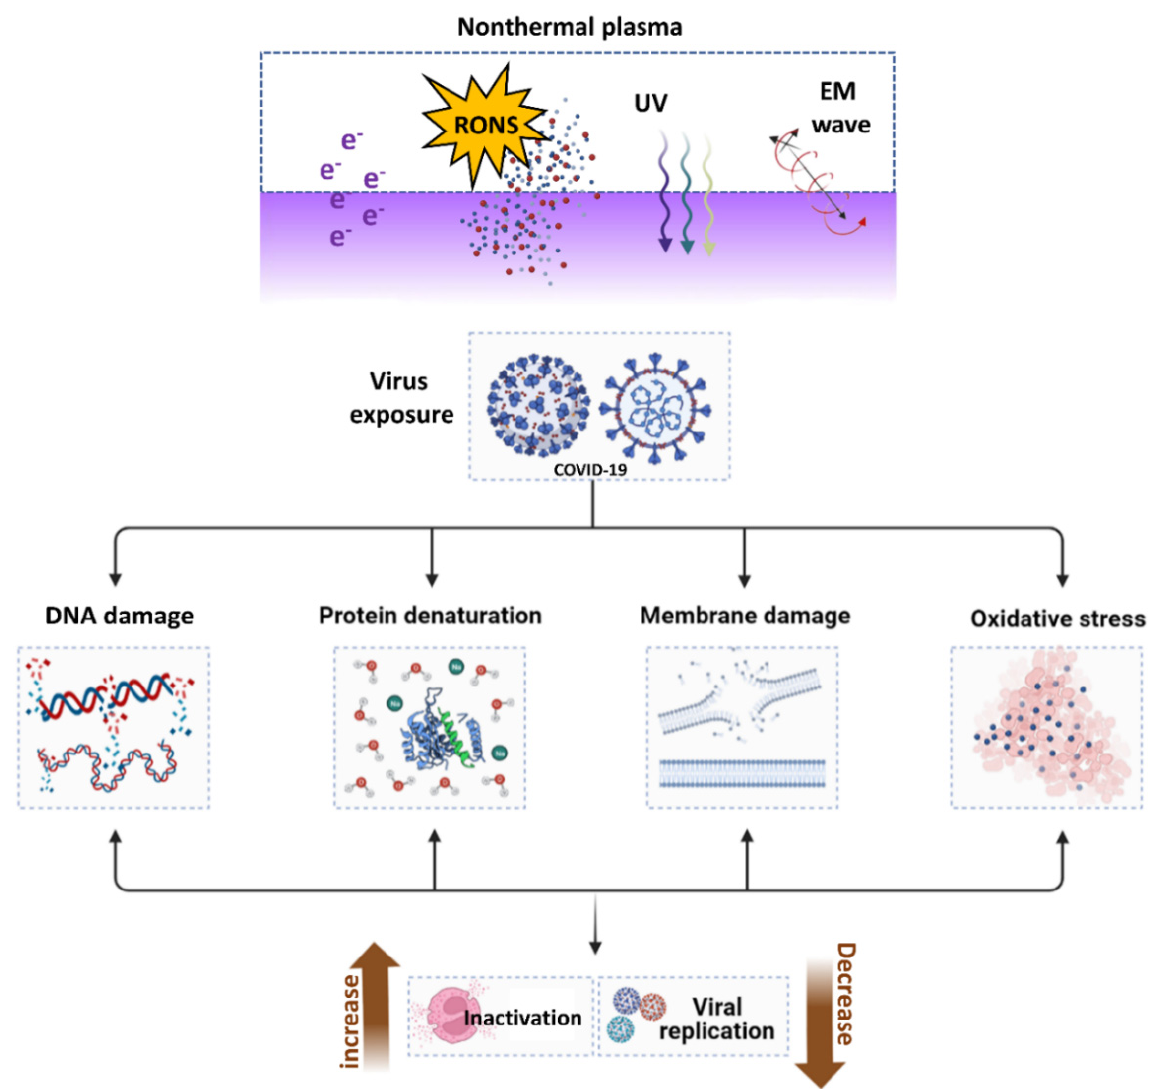
Figure 10. The mechanisms of NTAP in microorganisms in response to biological challenges. The NTAP is a cocktail of reactive species, UV, and RONS that is beneficial in iniactivating COVID-19 through DNA damage, protein denaturation, membrane damage, and oxidative stress, which ulti- mately results in the virus being rendered inactive or restricted to replication.